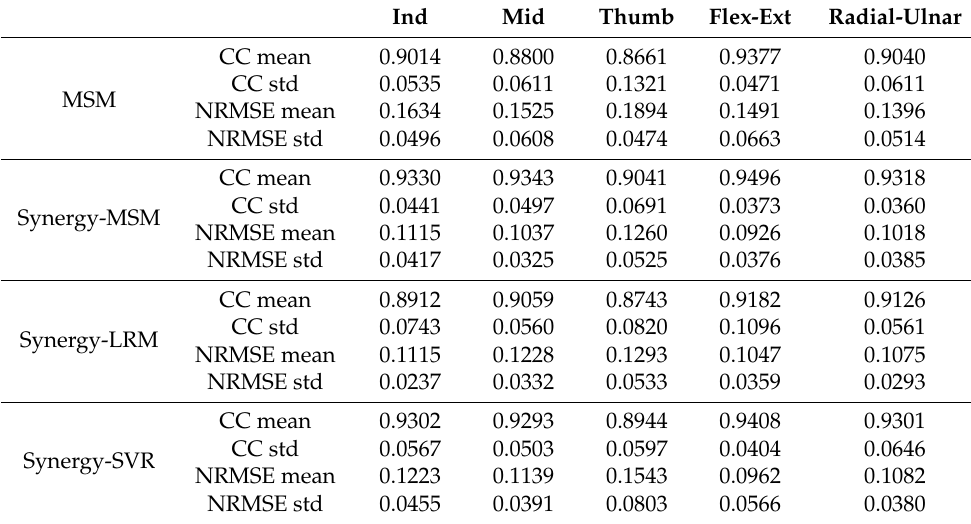
Table 1. Average statistics for various